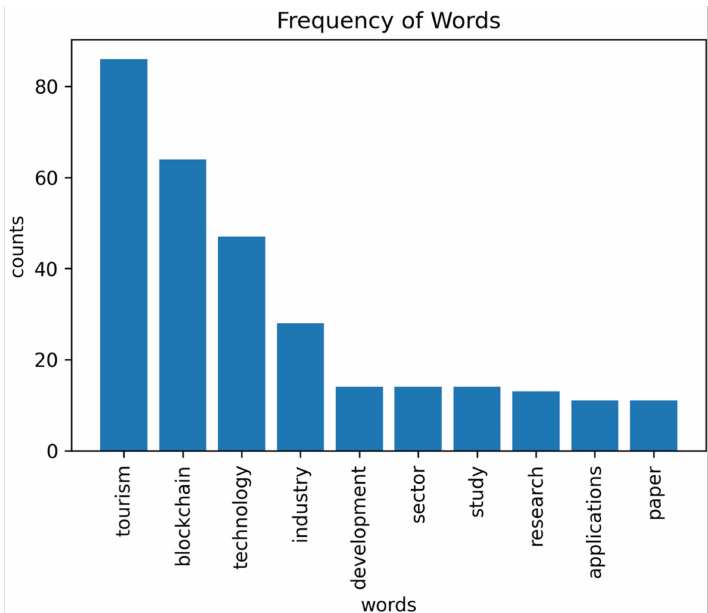
Figure 8. Frequency of words for the abstract. Source: Authors’